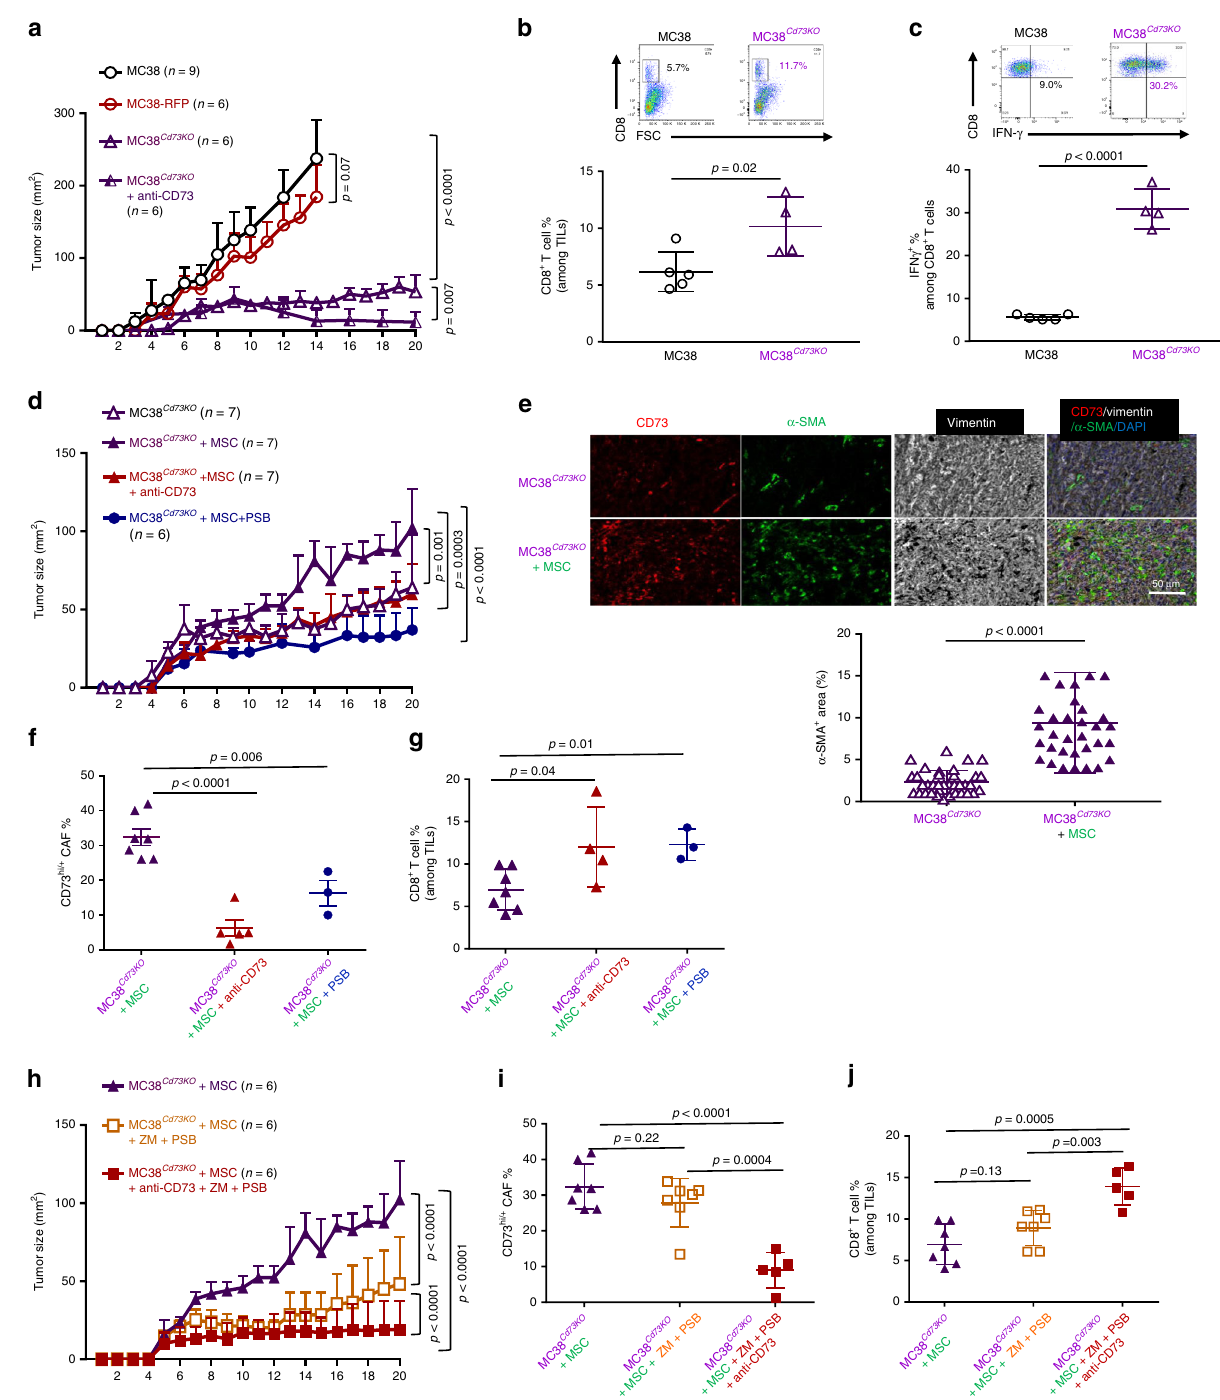
Fig. 8 The synergistic effects of combined adenosinergic antagonism and CD73 blockade on tumor control is CAF-dependent. a The progression of MC38 Cd73KO and MC38-RFP in WT mice was compared the unmodi fi ed MC38 tumors. A group of MC38 Cd73KO - bearing mice also received i.p. injection of anti-CD73 every other day. Tumor progression was examined every day. b The percentage of TIL-CD8 T cells and c IFN- γ -producing CTLs in the TME of MC38 and MC38 Cd73KO were determined via FACS and summarized. d – g The progression of MC38 Cd73KO tumors established in WT mice with MSCs co- inoculation with or without anti-CD73 or PSB1115 treatment was examined every day d . e CD73 + (red) and α -SMA + (green) cells and their distribution within the TME of MC38 Cd73KO tumors without or with MSC co-inoculation were analyzed and quanti fi ed via IHC. f , g The percentage of CD73 hi/ + CAFs ( f ) and TIL-CD8 T cells ( g ) in the TME MC38 Cd73KO tumors co-inoculated with MSCs following different treatments were determined via FACS and summarized. h – j The progression of MC38 Cd73KO tumors co-inoculated with MSC and treated with ZM243185 and PSB1115 combination in the absence or presence of anti-CD73 was examined every day g . i , j The percentage of CD73 hi/ + CAFs i and TIL-CD8 T cells j in the TME MC38 Cd73KO tumors with MSC co-inoculation following different treatments were determined via FACS and summarized. a , d , g p values were determined via multiple t -tests where the tumor sizes at each time point were compared. b , c , e , f , i , j Error bars depict mean ± SEM. p values were determined via two-tailed unpaired Student ’ s t - test. All experiments were repeated at least two times. Source data are provided as a Source Data fi